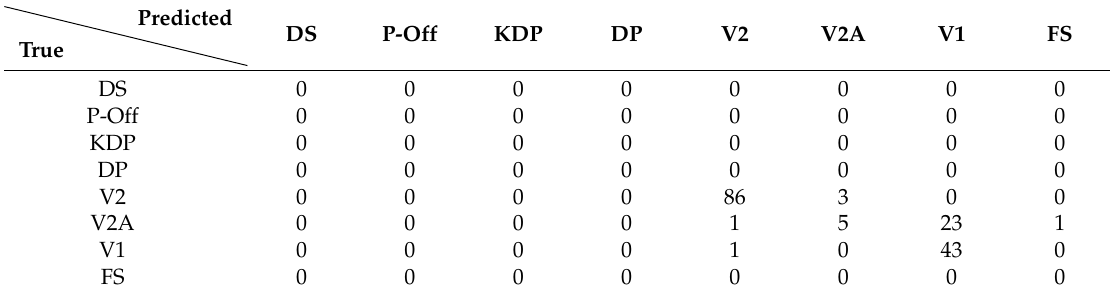
Table 12. Confusion matrix for the natural course, skating style validation set of skier 3 when using the sports biomechanics configuration of sensors.